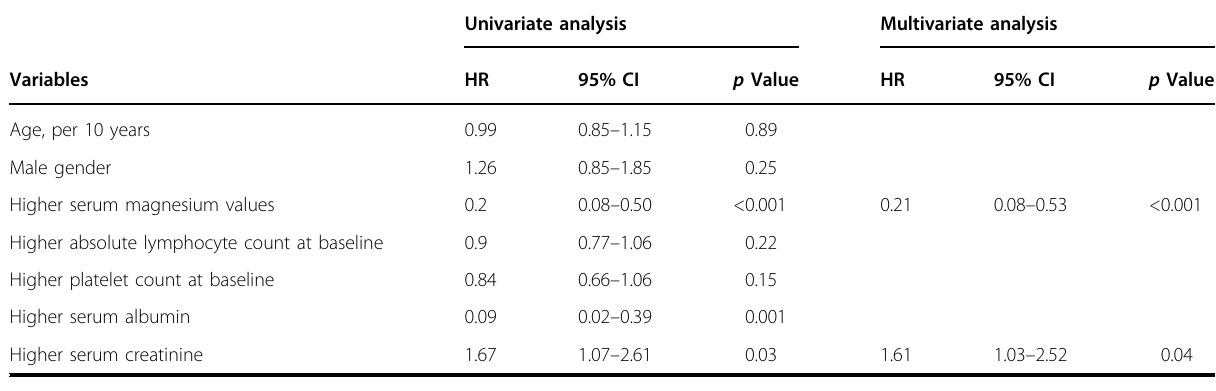
Table 2 Univariate and multivariate analysis of vs overall survival at 1 year (Cox proportional hazards regression model using continuous variables).